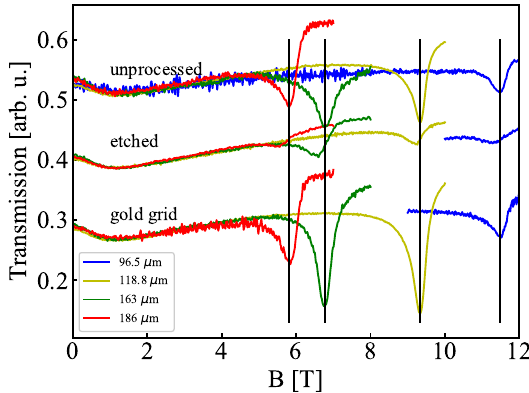
Figure 4. Transmission spectra of samples from the wafer B. In the case of both etched and Au gratings, the period of the grating was equal to 8 µ m and α ≈ 0.5 (see Appendix A for a definition of α ) . Vertical bars indicate the position of the CR. The wavelenght of radiation used is indicated in the